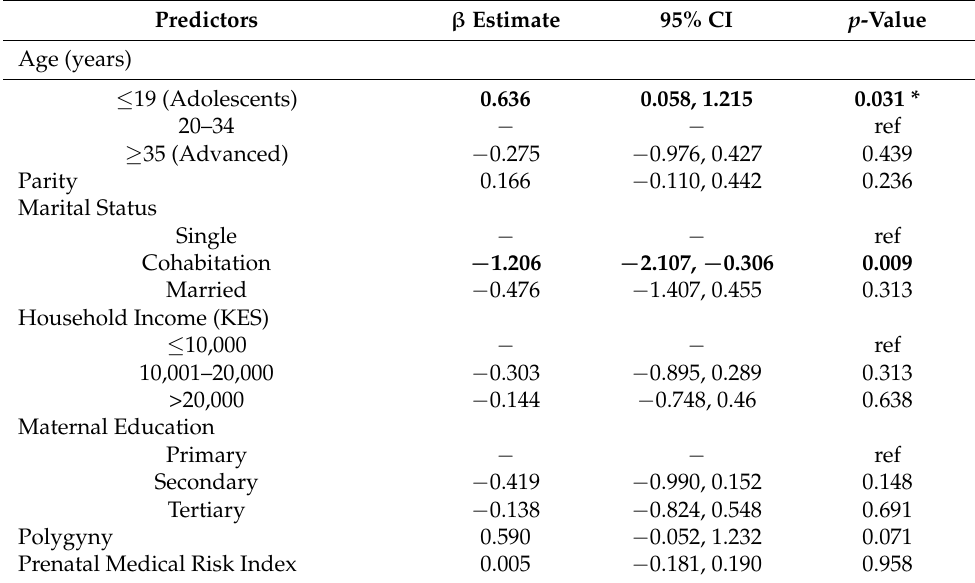
Table A9. Results of multivariate regression for the ratio of cortisone to